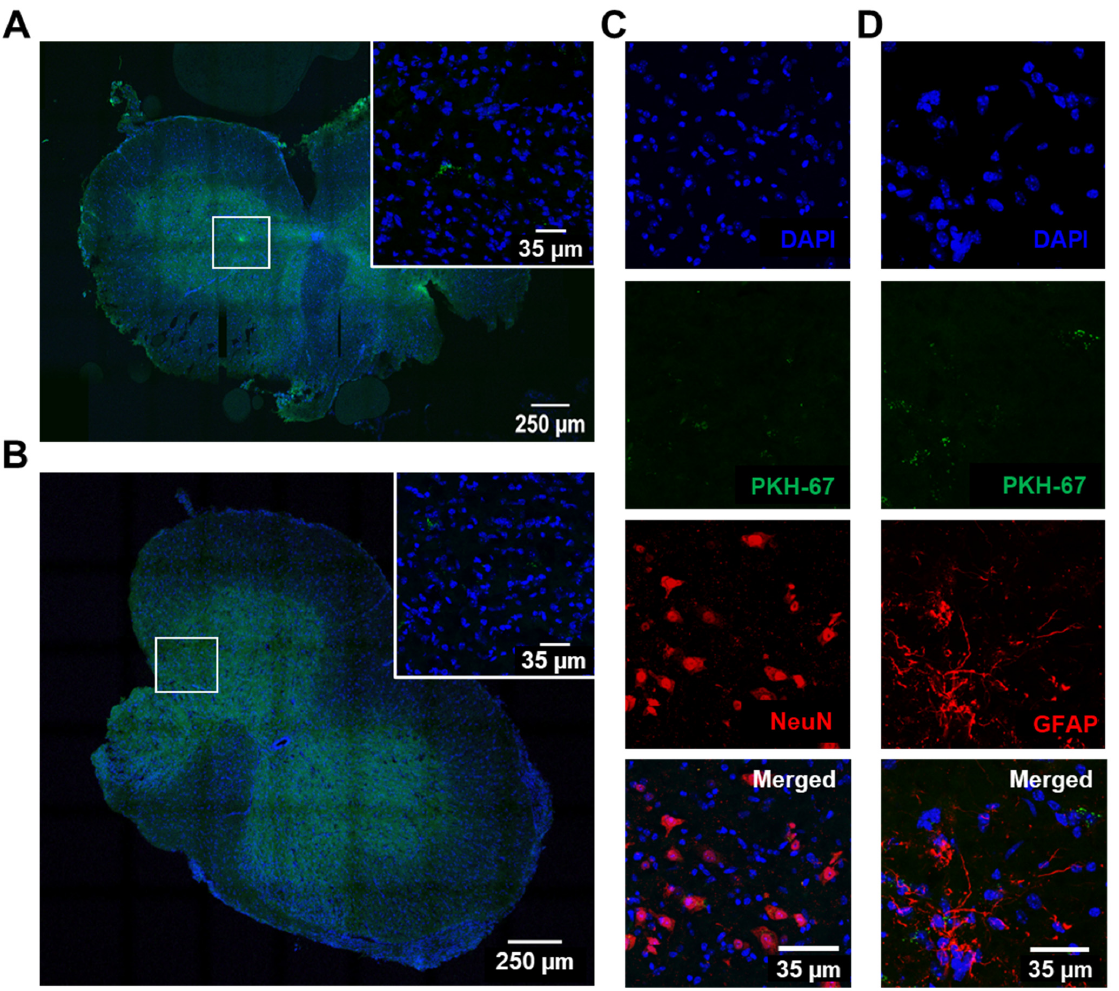
Figure 2. Intrathecal injection of labelled small extracellular vesicles (sEVs) in 12-week-old wild-type (WT) animals leads to their dissemination and interaction with nerve cells, as observed in the lumbar spinal cord (SC) sections at 8 h and 72 h after administration. sEVs were isolated by differential ultracentrifugation and labelled with PKH67 cell linker before injection in the WT mice, which were sacrificed at 8 h and 72 h thereafter. ( A , B ) Representative images of transversal SC slices with labelled sEVs (green) and respective insets at ( A ) 8 h and ( B ) 72 h post-injection. ( C , D ) Representative images of PKH67-labelled sEVs distributed among ( C ) NeuN-stained cells and ( D ) GFAP-stained cells from the lumbar SC of WT mice 72 h after injection. The nuclei were stained with DAPI (blue). DAPI, 4 ′ ,6-diamidino-2-phenylindole; GFAP, glial fibrillary acidic protein; NeuN, hexaribonucleotide binding protein 3.